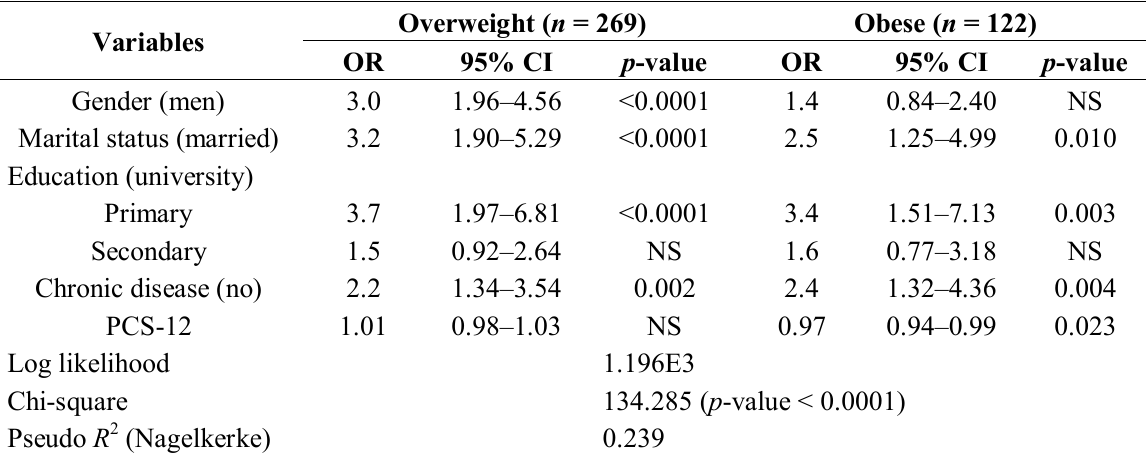
Table 3. Factors predicting physician consultations according to multinomial logistic regression analysis.